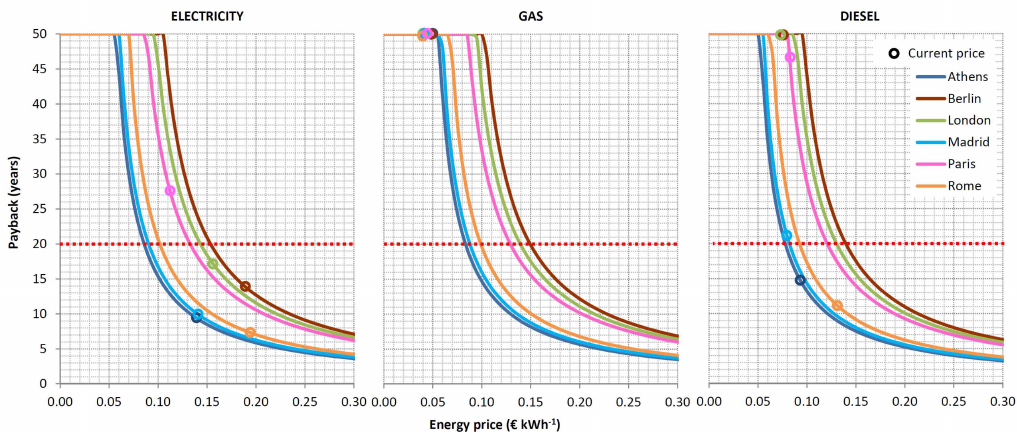
Figure 7. Payback variations produced by changes in the energy price of the conventional supply